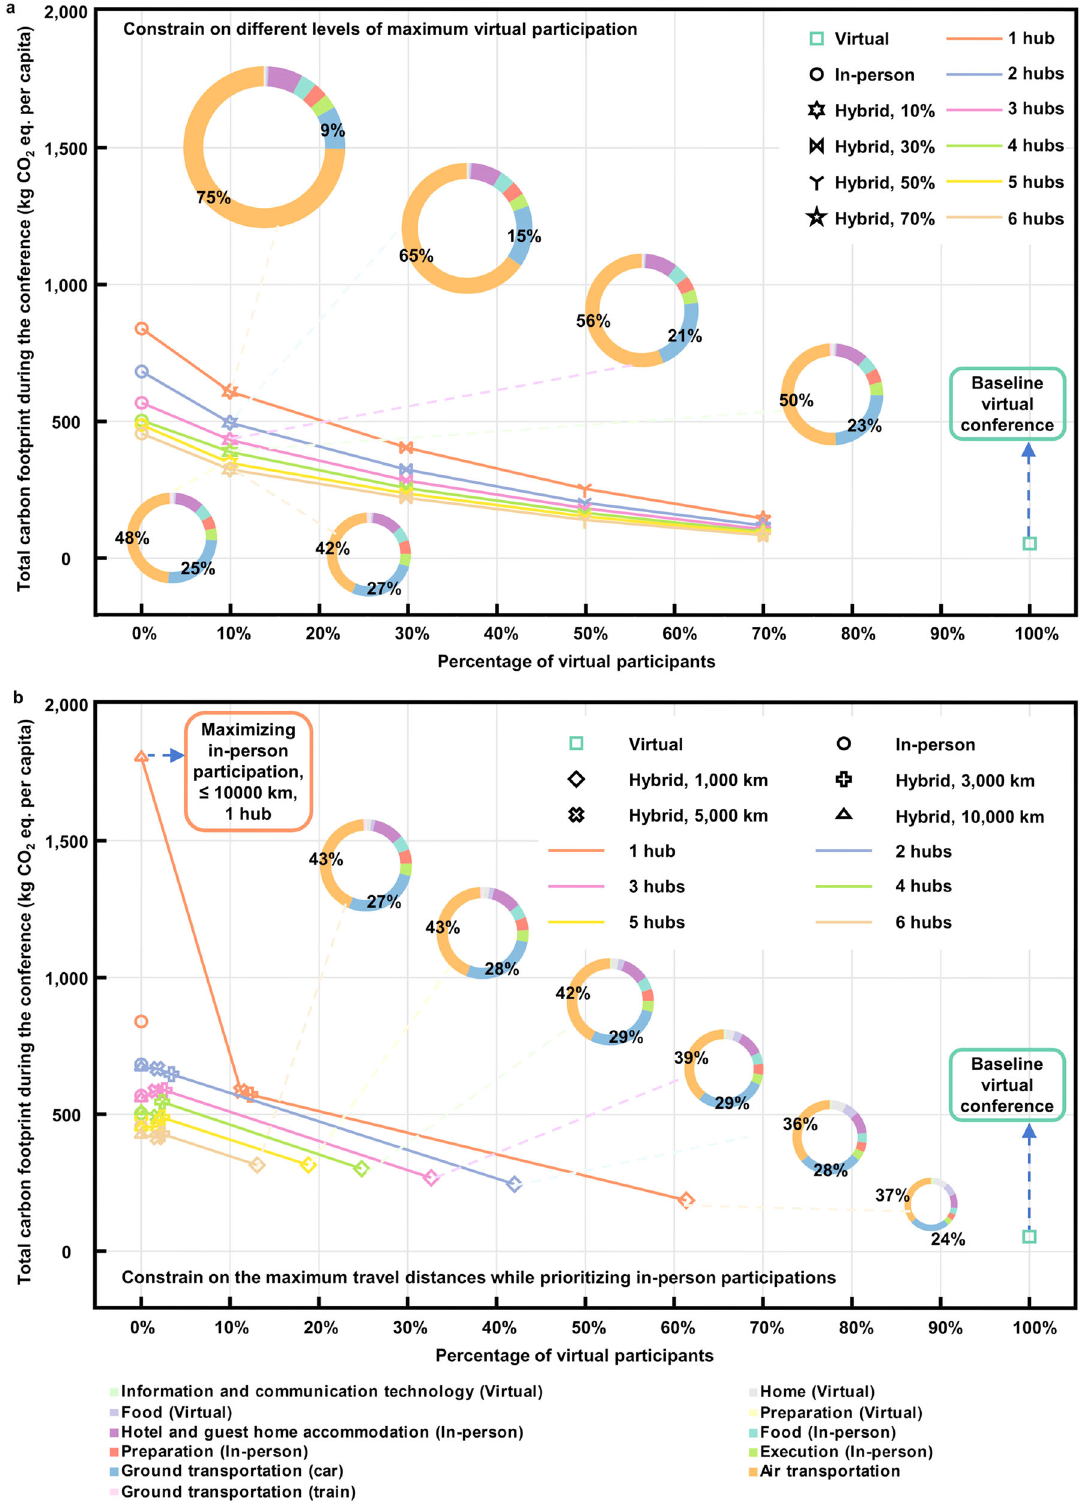
Fig. 5 Trade-offs between face-to-face communication and carbon footprint. Different markers indicate the results of different scenarios, and their colors refer to the number of conference hubs. Doughnut charts represent the breakdowns of scenarios, pointed by the blue dashed lines. a Comparison between the hybrid scenarios with a constraint of the maximum virtual participation, the in-person scenarios, and the baseline virtual scenario. b Comparison between the hybrid scenarios with a constraint of the maximum travel distance, the in-person scenarios, and the baseline virtual scenario. CO 2 eq., CO 2